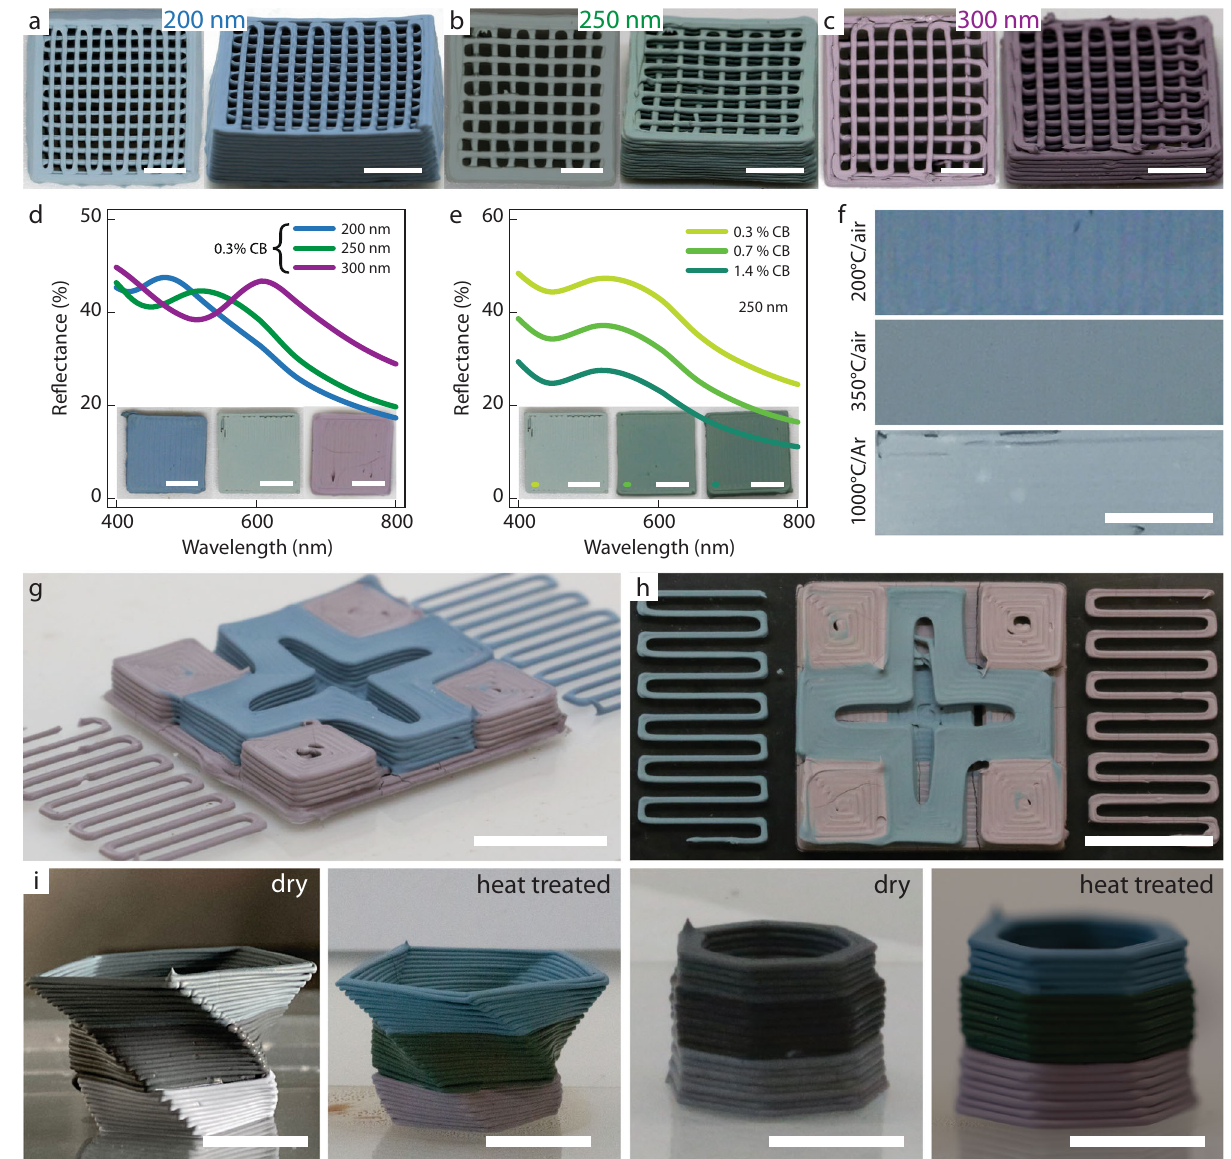
Fig. 4 | 3D printed objects with isotropic structural color. Grid-like structures printed from inks containing a 200nm, b 250nm, and c 300nm silica colloids. Re fl ectance spectra of 3D printed and heat treated specimens prepared using d different silica particle sizes and fi xed carbon black content of 0.3wt%, and e differentcarbonblack(CB)concentrationsand fi xedsilicaparticlesizeof250nm. f